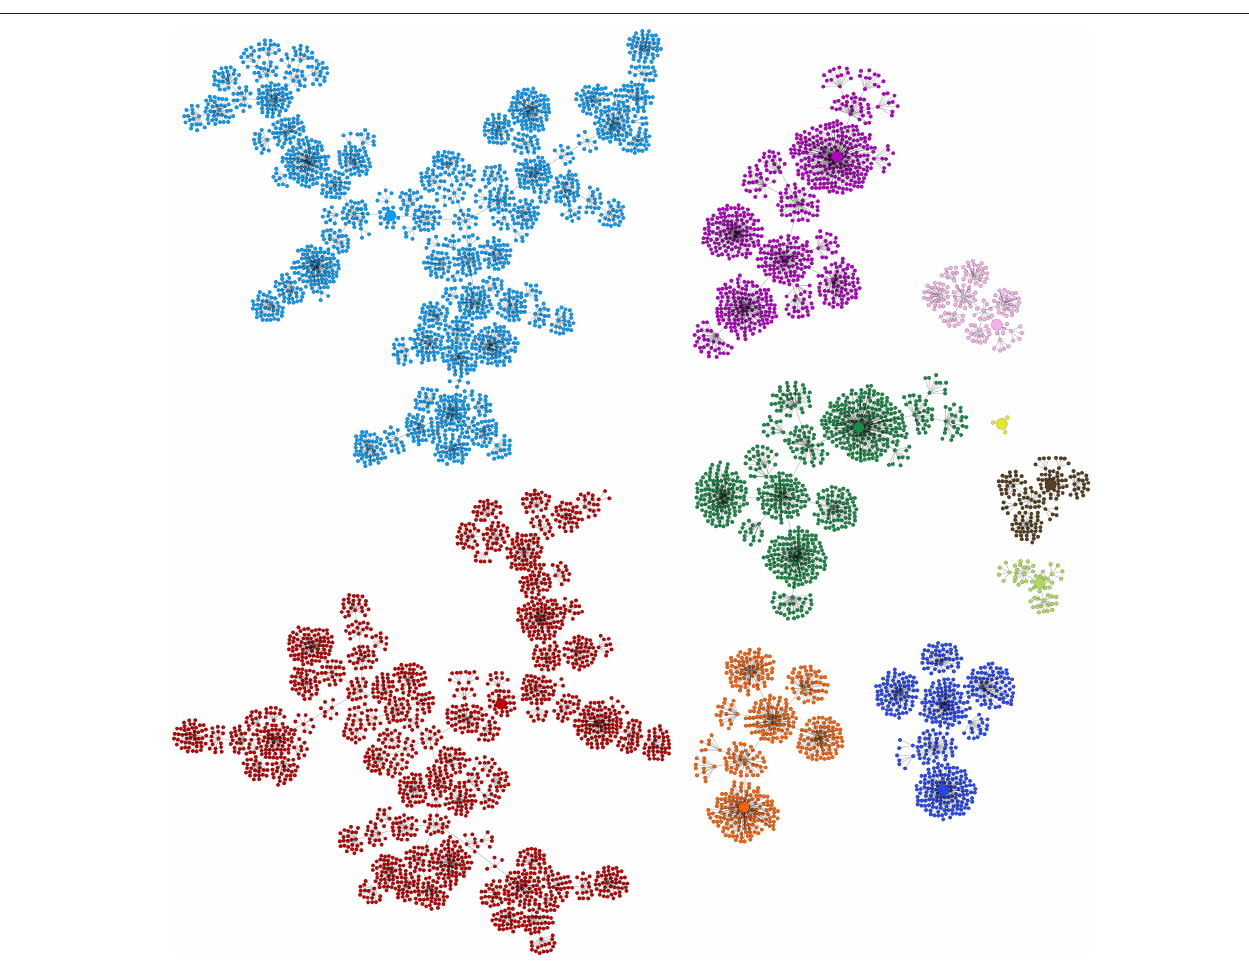
FIGURE 7 | Depiction of basins of attraction for the ten known fixed-point attractors corresponding to the Boolean network having the combination of basin sizes reported in the sixth row in Table 3 . The biggest component with 2,488 states corresponding to ST2 is colored red, the second biggest with 2,432 states, corresponds to CA and is colored light blue, I1 is colored purple, I2 dark green, I3 dark blue, I4 orange, SE brown, PE1, the smallest component with only four states, is colored yellow, PE2 pink and ST1 light green. The fixed-point attractors are represented by bigger circles than those of non stationary states. Griffin use the algorithm of Dubrova and Teslenko (2011) to compute the attractors of the Boolean networks. Binary Decision Diagrams and the backward reachable set algorithm of Garg et al. (2008) are applied to each attractor to compute their corresponding basins.